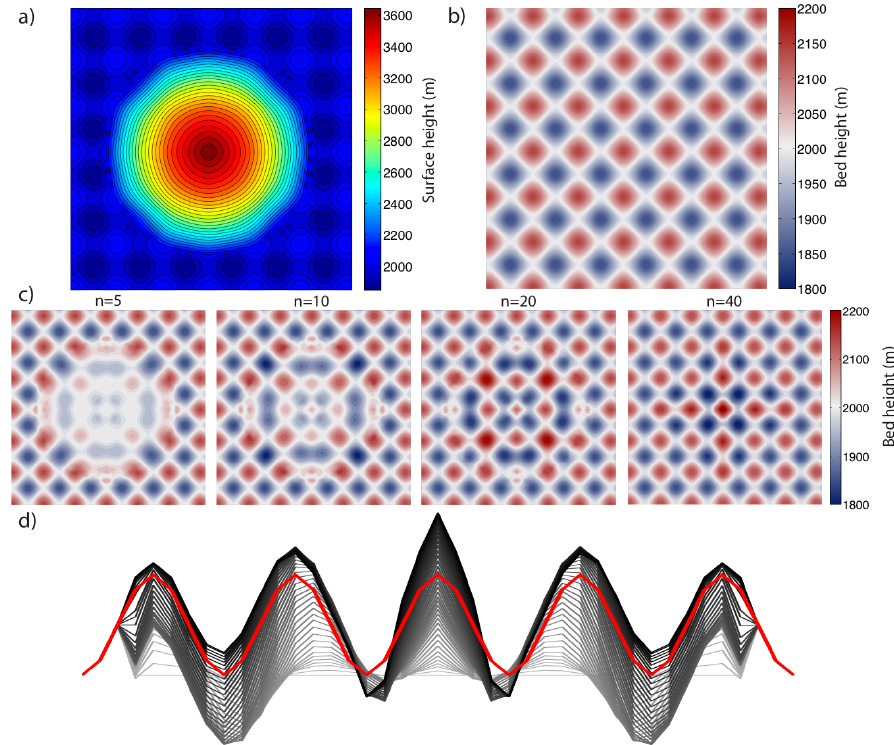
Fig. 3. Recovery of a field of bumps with an amplitude of 150m. The reference surface and bed are shown in (a) and (b) . Panel (c) shows snapshots of the recovered bed height after n = 10, 20, 30 and 40 iterations. In (d) the gradual recovery of the bed is depicted with every line representing the bed after a certain iteration while the grayscale is a measure for the iteration number (low is light gray, high is black); the red line marks the reference bed height.